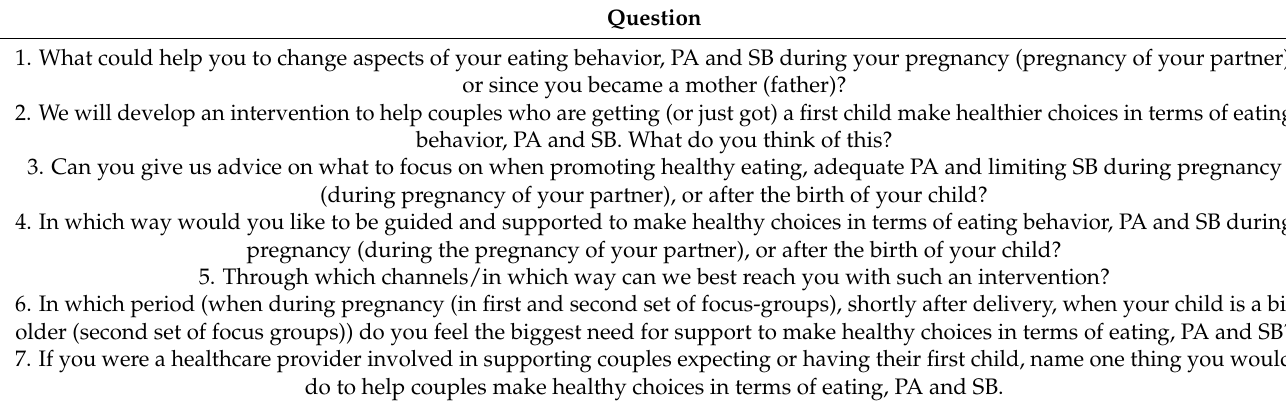
Table 1. Question guide about intervention